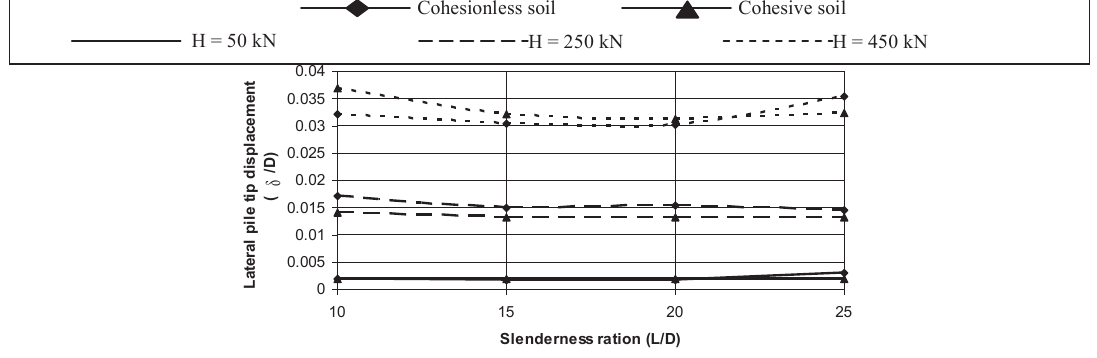
Figure 5: Predicted lateral tip displacement versus pile slenderness ratio under the influence of lateral load intensities.